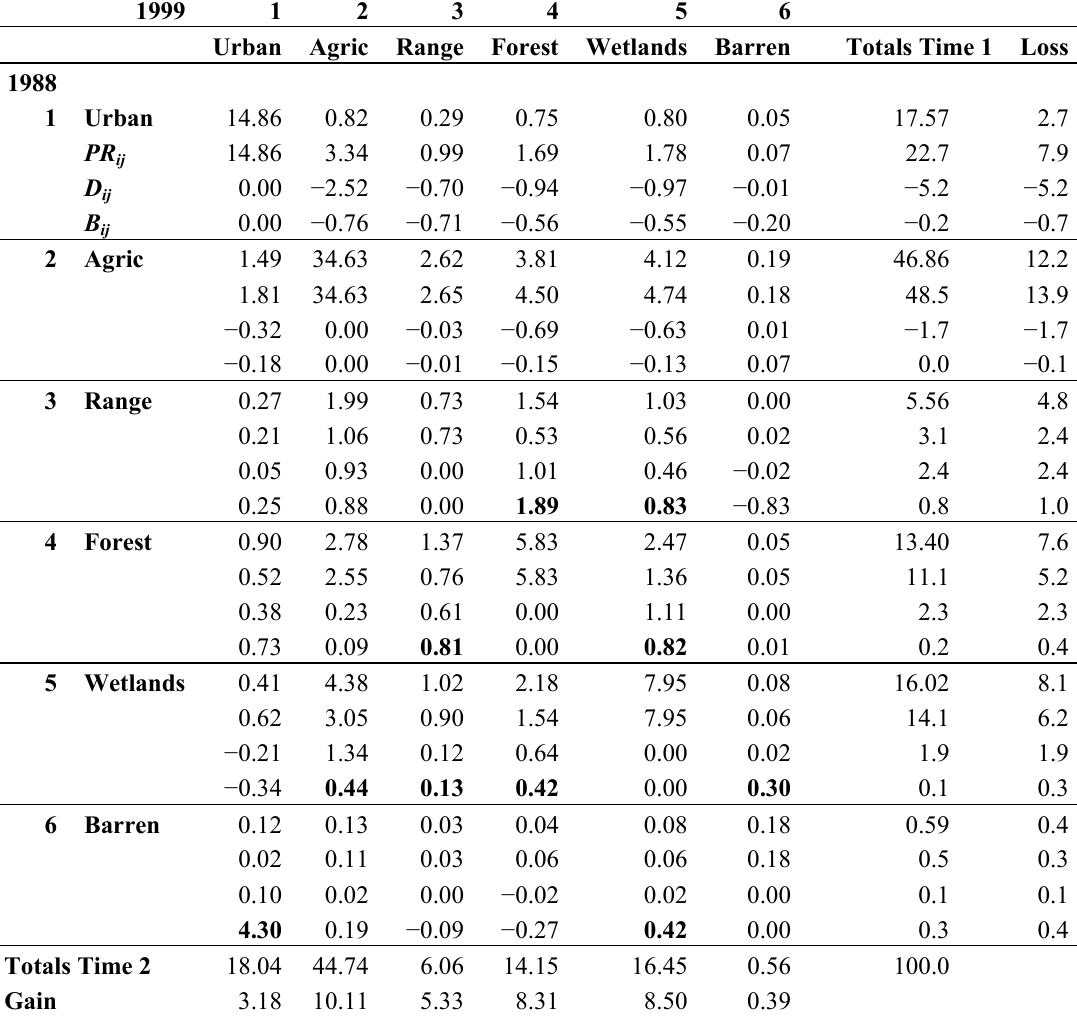
Table 4. Inter-category changes in the Caloosahatchee River Watershed in 1988–1999: Focus on